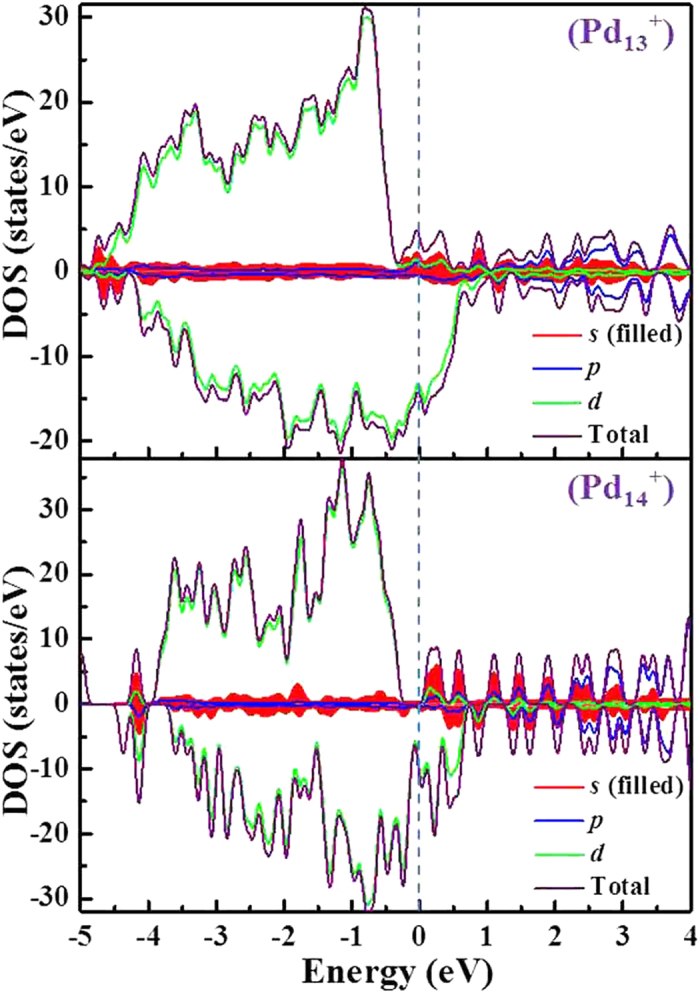
The density of states (DOS) of Pd13+ and Pd14+ clusters.The Fermi level is shifted to zero.